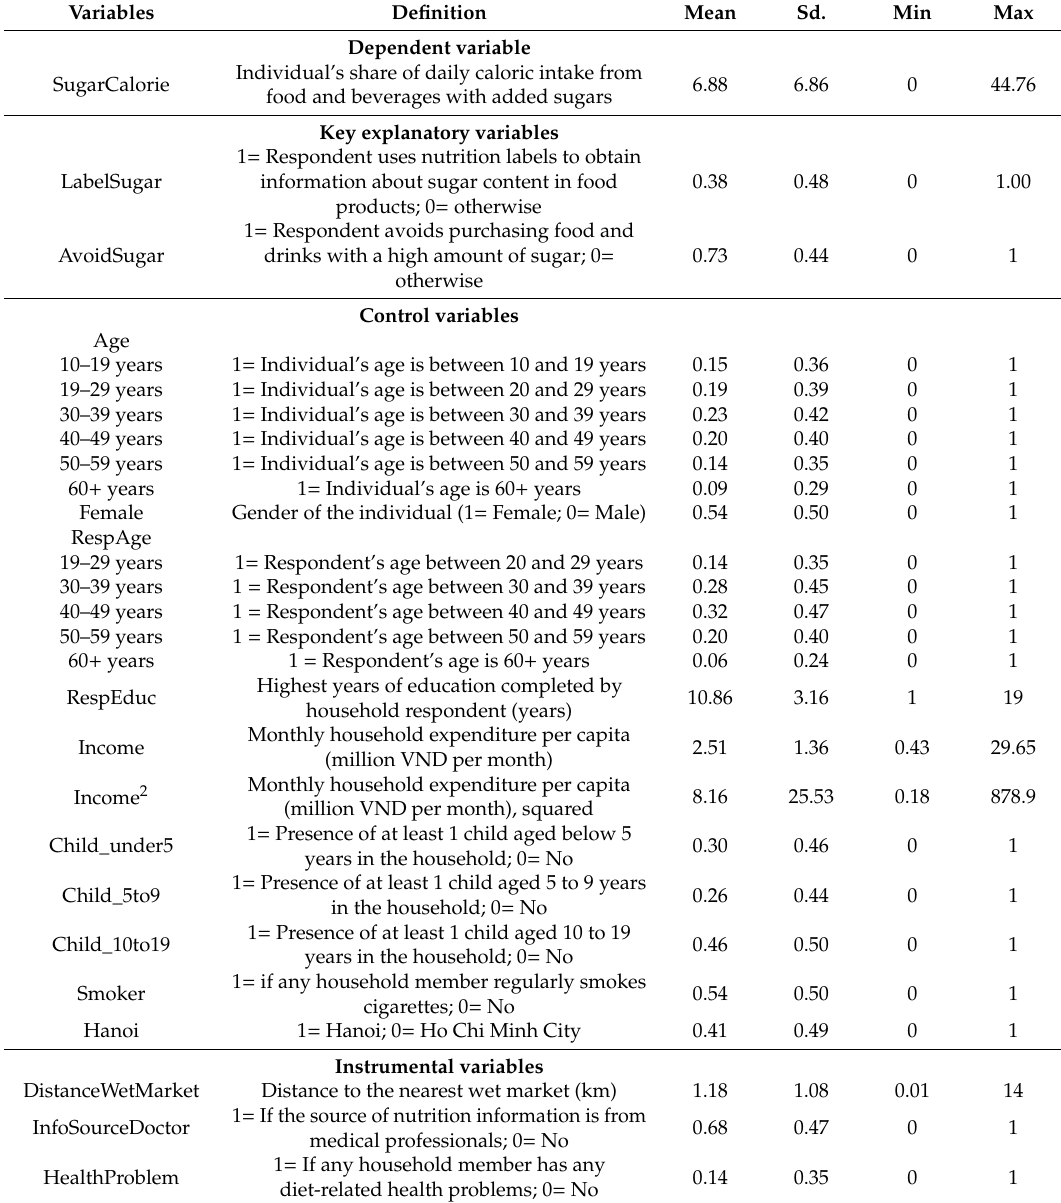
Table 1. Descriptive statistics of variables included in the